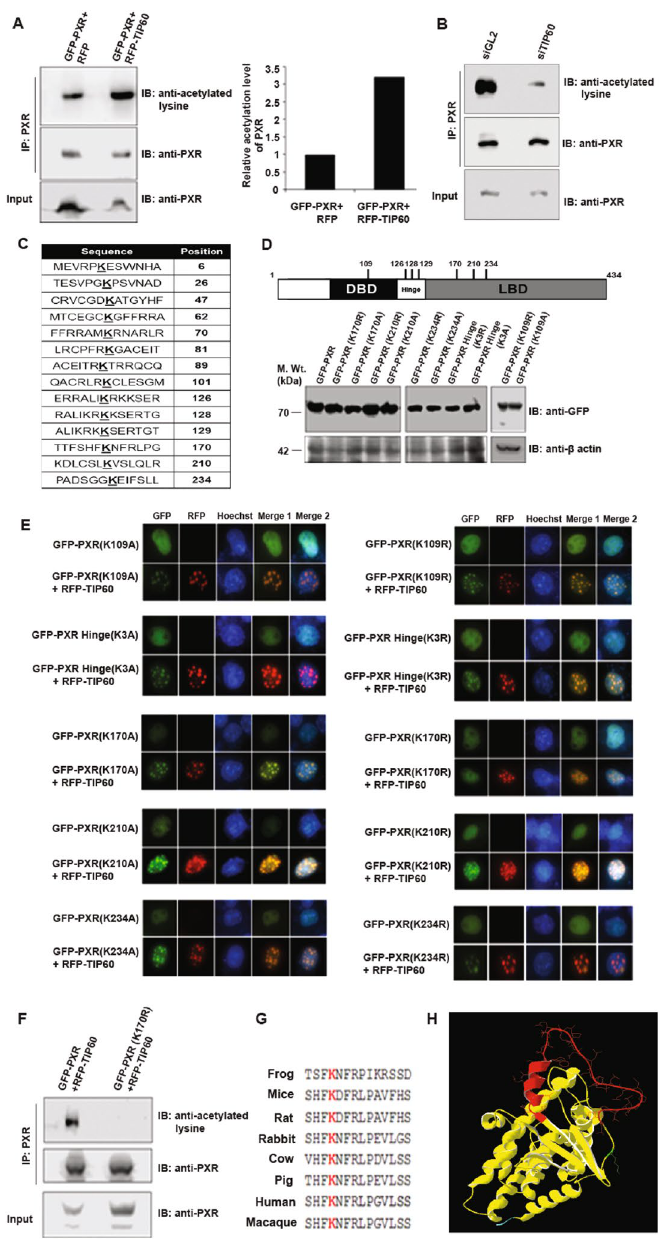
Figure 4. TIP60-mediated acetylation of lysine 170 of PXR is essential for TIP60-PXR foci formation. ( A ) GFP-PXR was cotransfected with RFP-TIP60 or RFP vector in Cos-1 cells. Harvested cells were subjected to immunoprecipitation with anti-PXR antibodies followed by immunoblotting performed with anti-acetylated lysine or anti-PXR antibody. Band intensities were measured using C-digit scanner and graph was plotted for obtained values. ( B ) Cells were transfected with siTIP60 or siGL2 followed by GFP-PXR transfection. Anti-PXR antibody was used to immunoprecipitate PXR followed by immunoblotting with anti-acetylated lysine or anti-PXR antibody. ( C ) Table shows the putative acetylation sites in PXR protein predicted by PAIL software. ( D ) Schematic diagram shows the putative acetylation sites in PXR selected for the study. Western blot performed with anti-GFP antibody to detect expression of PXR and its acetylation-mimicking and acetylation-deficient mutant constructs cloned into GFP vector. ( E ) Acetylation of lysine residue 170 in PXR is essential for TIP60-PXR foci formation. Cos-1 cells were transfected with GFP-PXR or its lysine mutants alone or with TIP60 as indicated followed by live cells imaging. ( F ) TIP60 acetylates lysine 170 of PXR. GFP-PXR or GFP-PXR (K170R) along with RFP-TIP60 plasmids were transfected in Cos-1 cells. Immunoprecipitation was performed similar to panel A of Fig. 4 using anti-PXR antibody. Western blotting was performed with immunoprecipitated extract using anti-PXR or anti- acetylated lysine antibodies as indicated. ( G ) Sequence alignment showed lysine 170 to be conserved in PXR ortholog across different species as depicted in the figure. ( H ) Structure of PXR LBD. Red color highlights 174–210 region while green color shows the position of lysine 170. Blue color depicts the incomplete hinge region. Full- length immunoblots are presented in Supplementary Figure